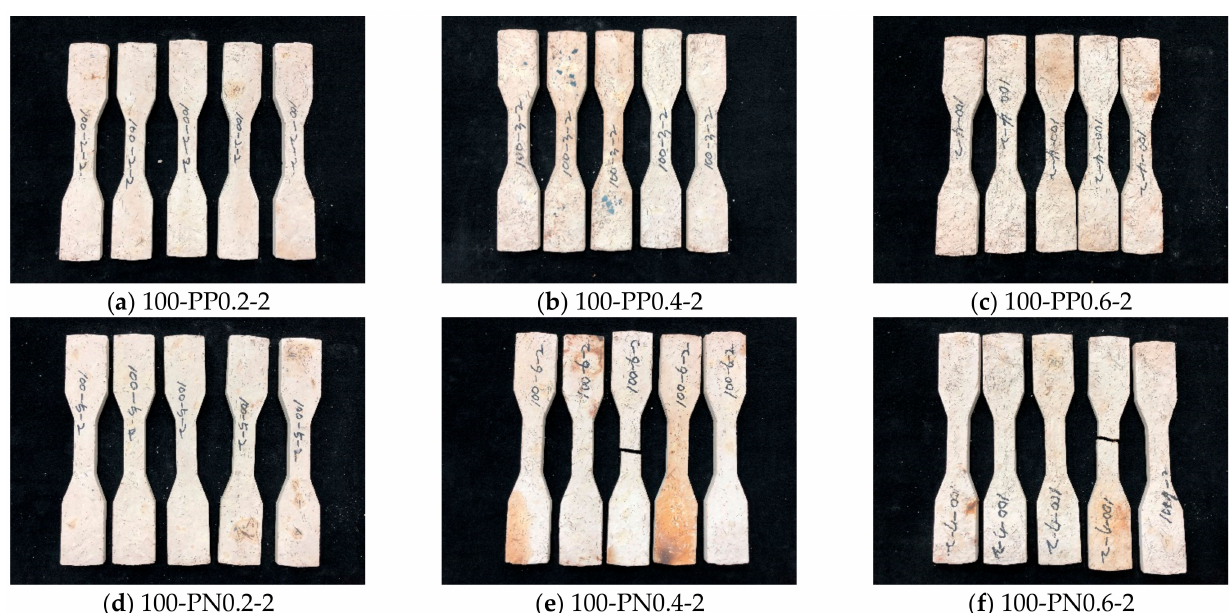
Figure A1. Appearance of the 100 MPa specimens after 2 h of fire exposure.